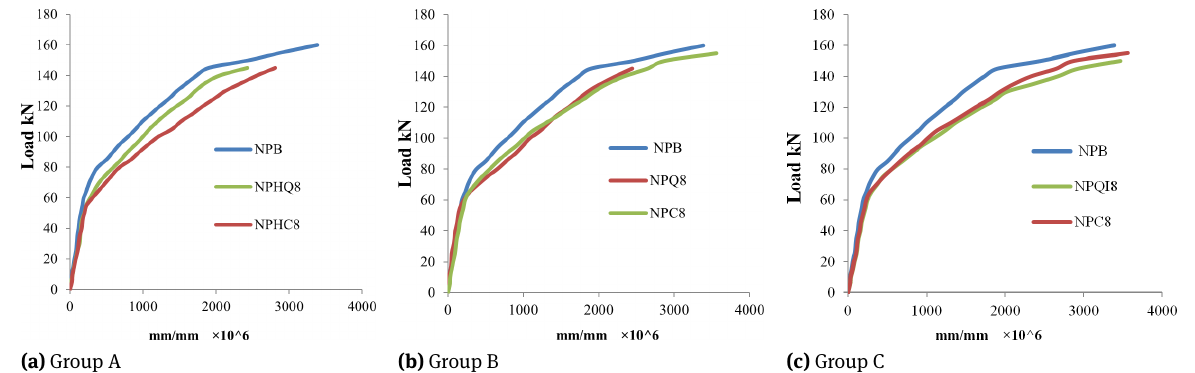
Figure 6: Load versus strain increment in unbounded reinforcement strand